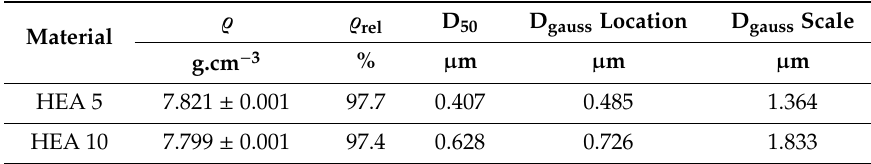
Table 1. Microstructural characteristics of examined HEAs.